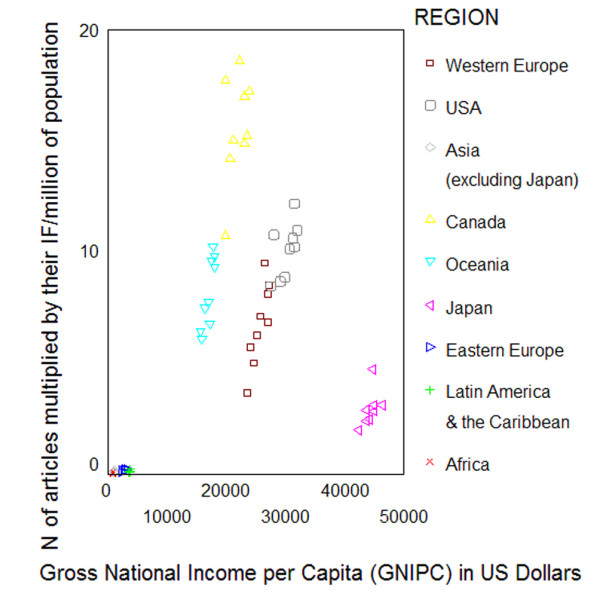
Relation of 'total product' adjusted for population to GNIPC. Scatter plot depicting the relationship of the annual "total product" of research productivity for different world regions (number of articles published multiplied by their impact factor) in Critical Care Medicine, with the population of a region and the gross national income per capita (GNIPC)